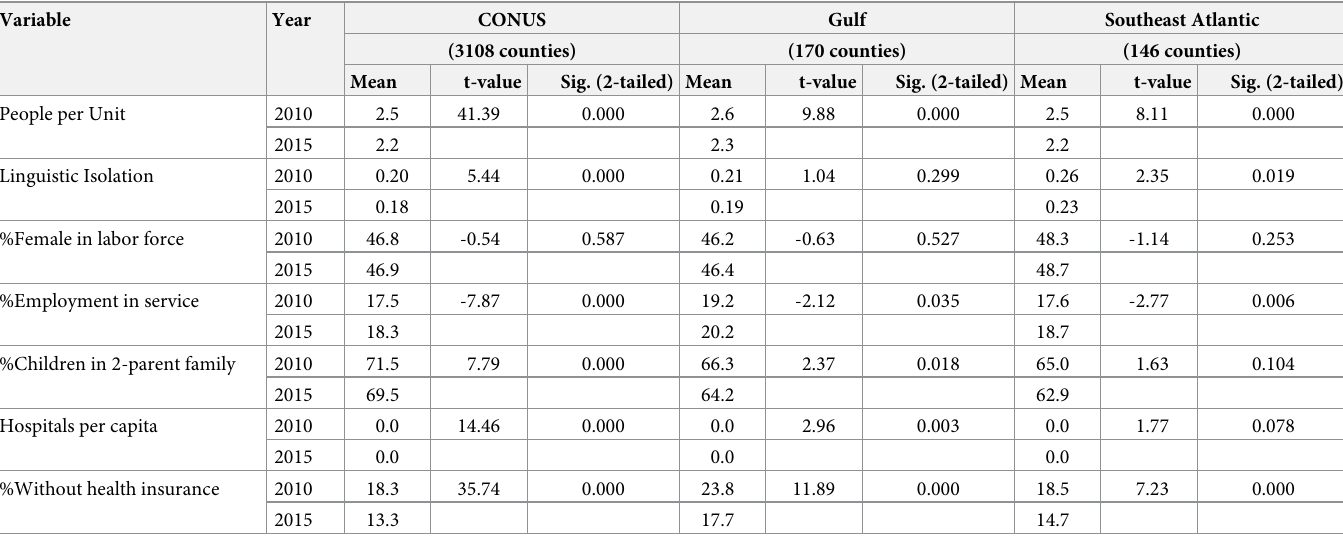
Table 3. Difference of means for SoVI input variables 2010 and 2015 �